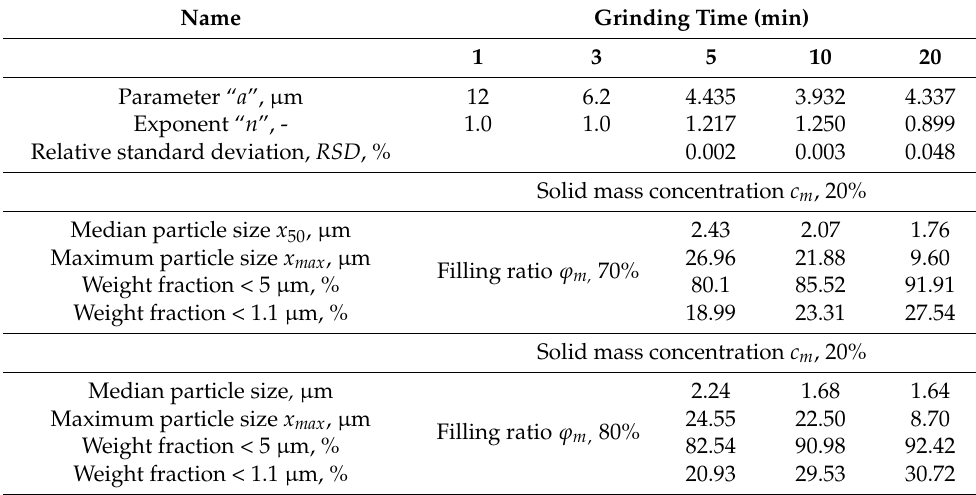
Figure 2. Values of parameter “ a ” depending on the grinding time. Table 4. Parameters of Rosin–Rammler function and particle size characteristics in stirred ball